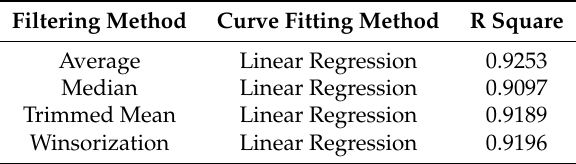
Table 4. RSSI to distance hall band